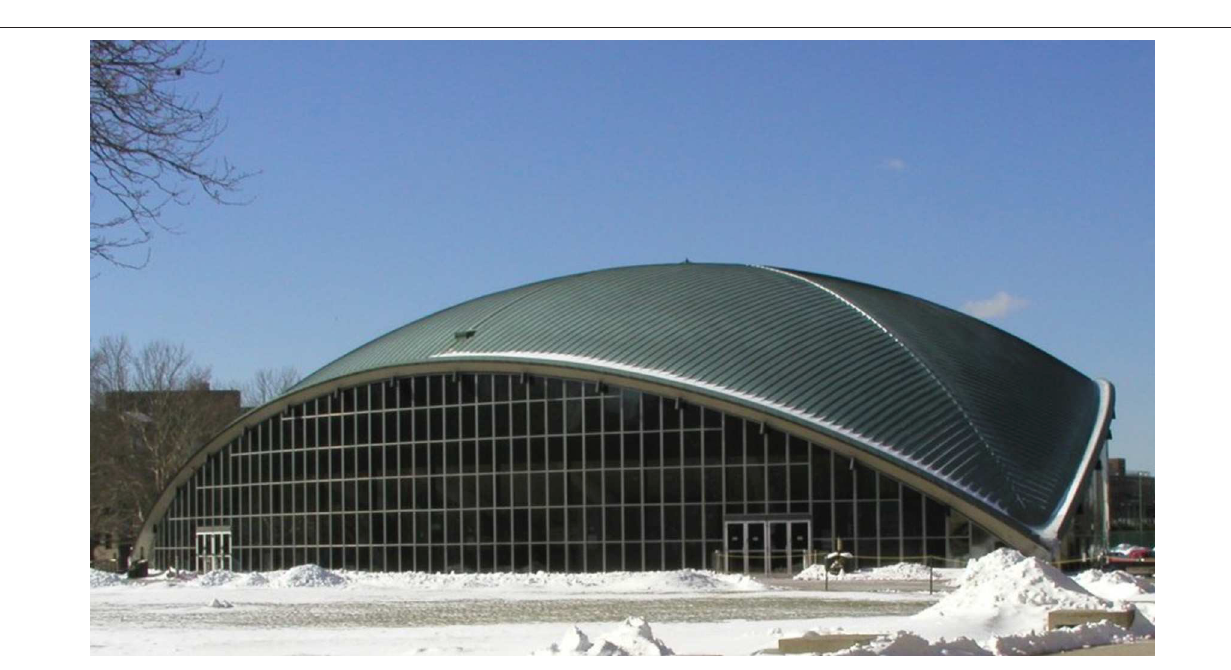
FIGURE 7 | Kresge Auditorium at MIT.